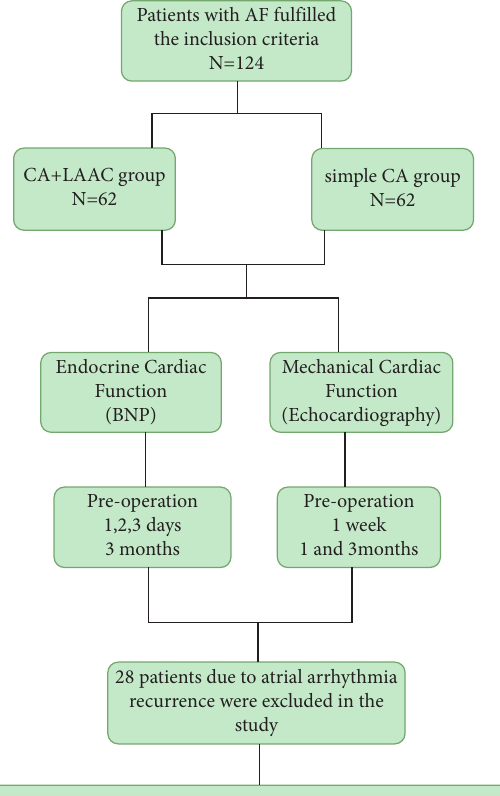
Figure 1: Flowchart of study procedure. LA, left atrial; BNP, brain natriuretic peptide; LAAC, left atrial appendage closure; CA, catheter ablation; AF, atrial